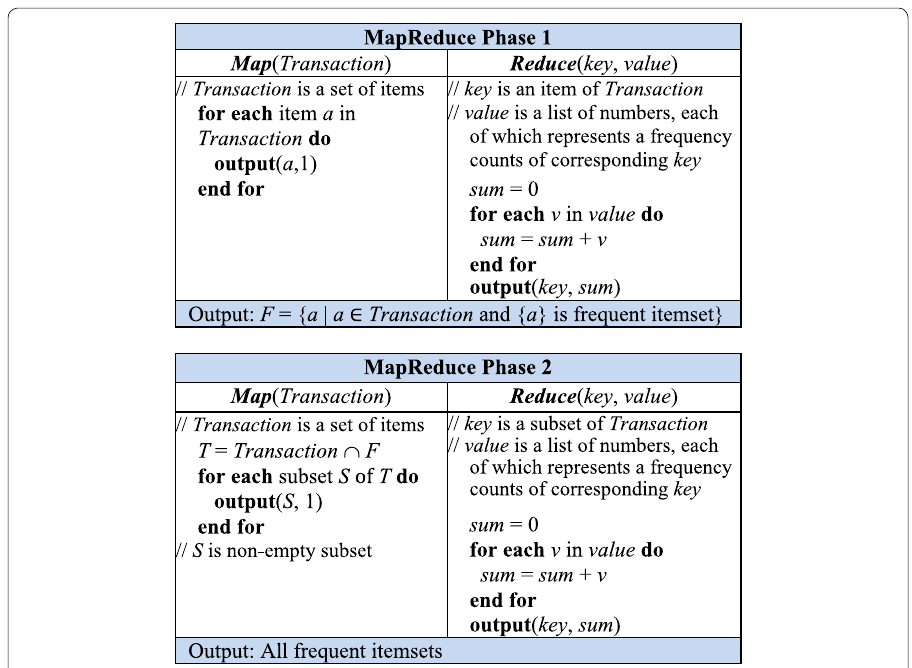
Fig. 3 Basic idea of AprioriPMR . Shown a basic concept of AprioriPMR of Phase 1 and Phase 2, in form of